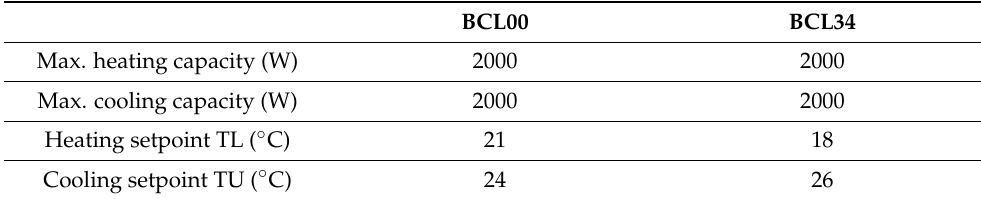
Table 5. Max. heating and cooling capacity and setpoints of the basic controller BCL00 and the adaptive controller BCL34.